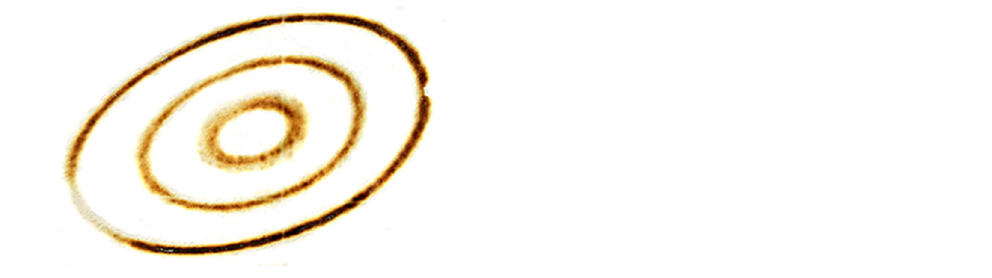
Figure 2. The raster pattern of the electron beams (EB) applied for the chitosan Electron-Beam Plasma (EBP)-processing. Table 1. The conditions of the chitosan EBP-processing.